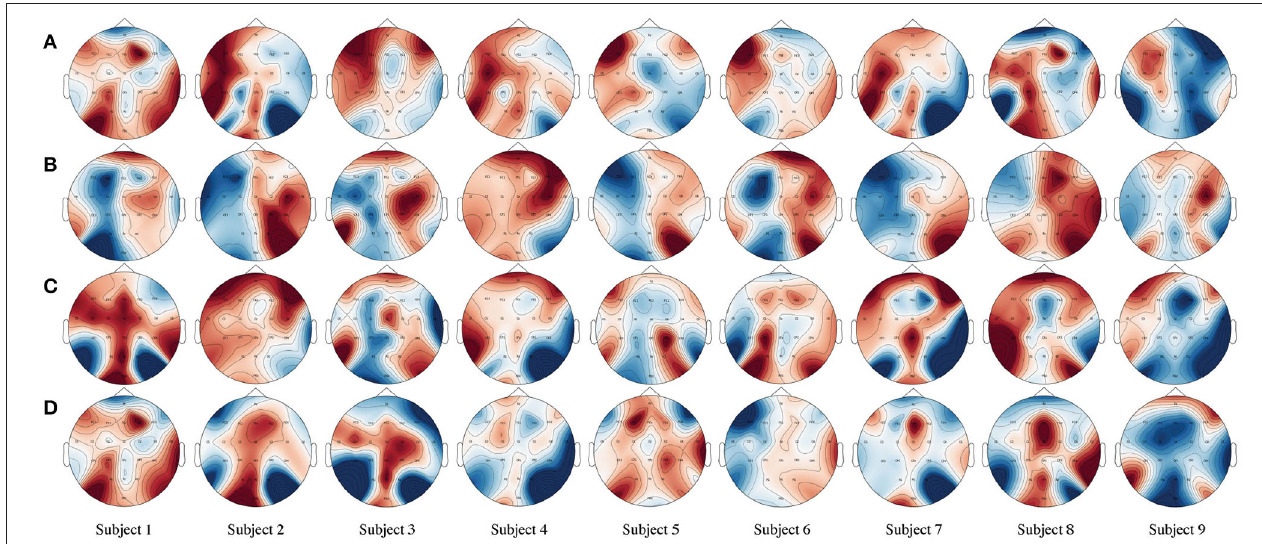
FIGURE 4 | Brain active correlation map corresponding to our classification results for each subject using four-class motor imagery (MI) unmanned aerial vehicle (EEG) signals from the BCIIV2a dataset. Twenty-two Ag/AgCl electrodes were used to record the EEG. (A–D) The MI of the left hand, right hand, both feet, and tongue for each line in the picture. The electrode C z is located on the center of the head. C 3 and C 4 are located on the left and right sides, respectively. These electrodes are positioned directly over the motor cortex areas. Red indicates a positive correlation, i.e., increasing amplitude values (ERS), whereas blue indicates a negative correlation, i.e., decreasing values